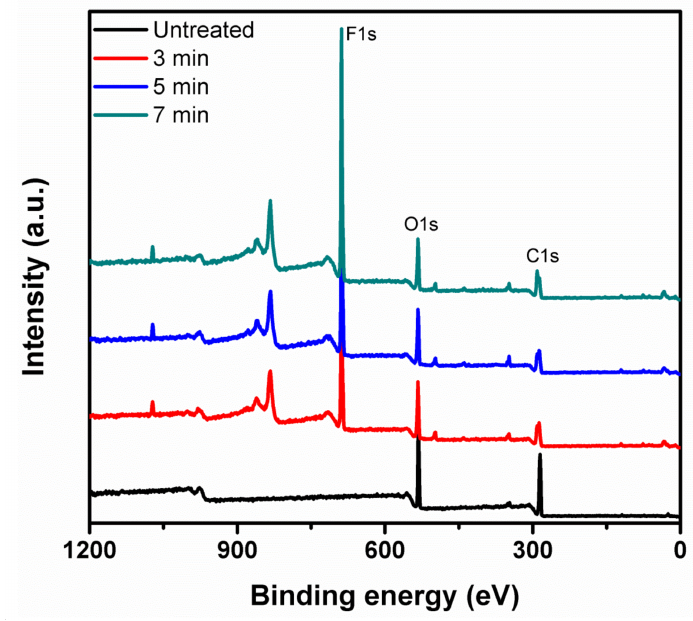
Figure 11. XPS analysis of full-survey spectra of untreated, 3 min, 5 min, and 7 min at 200 mTorr 50 Watts.